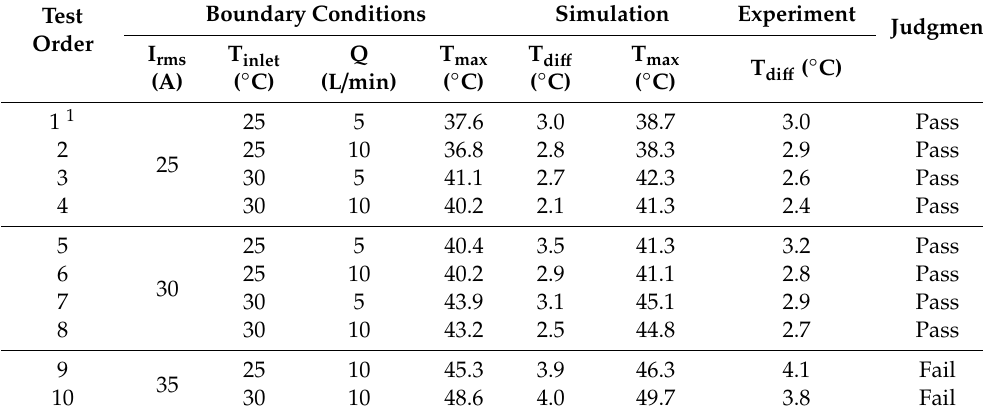
Table 6. Comparison of the experimental results and numerical results.